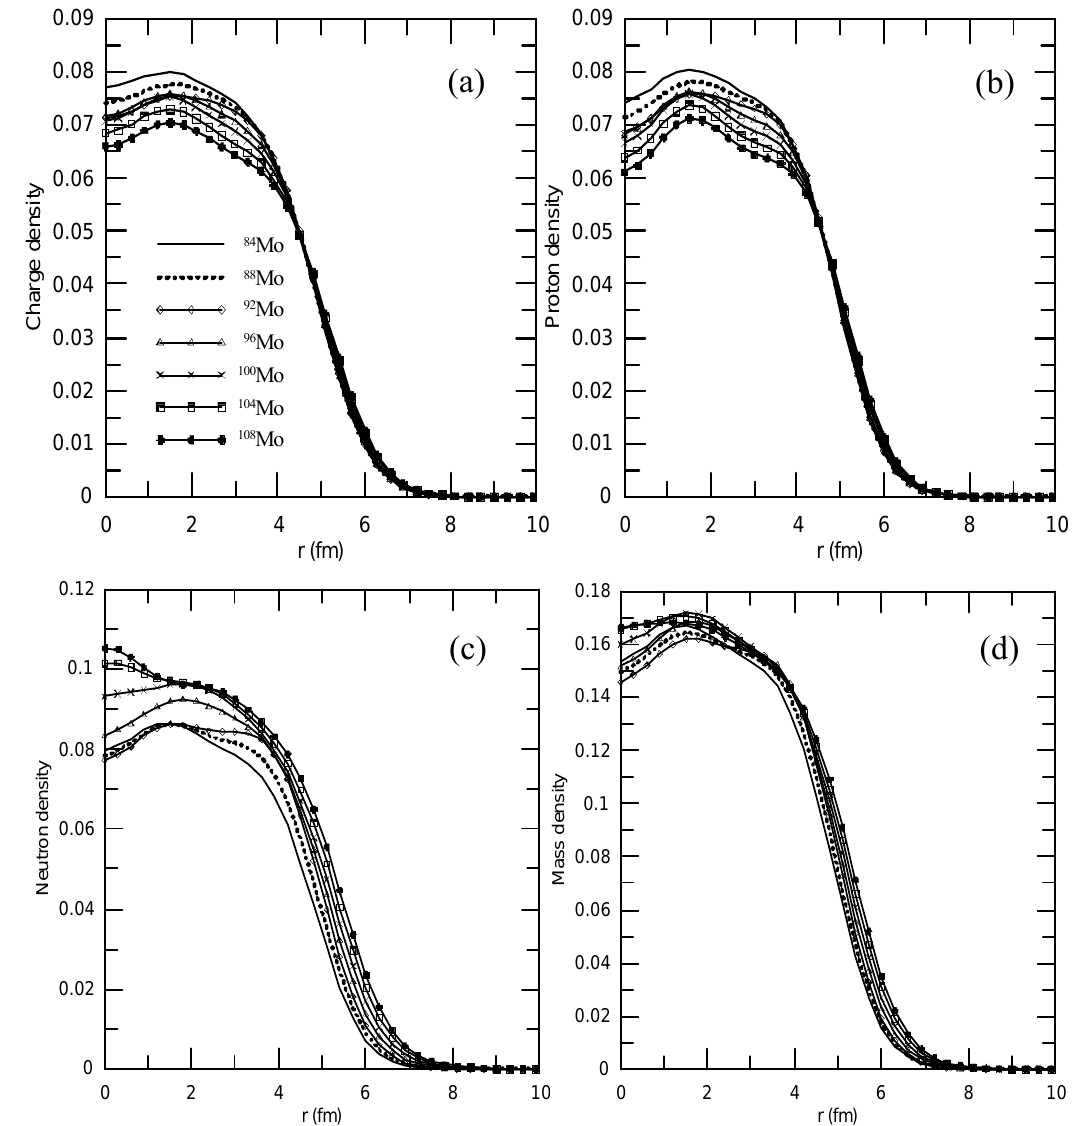
Fig.2: The density distribution of the 84-108 Mo isotopes using SkM Skyrme parameterization. (a) charge density, (b) proton density, (c) neutron density and (d) mass